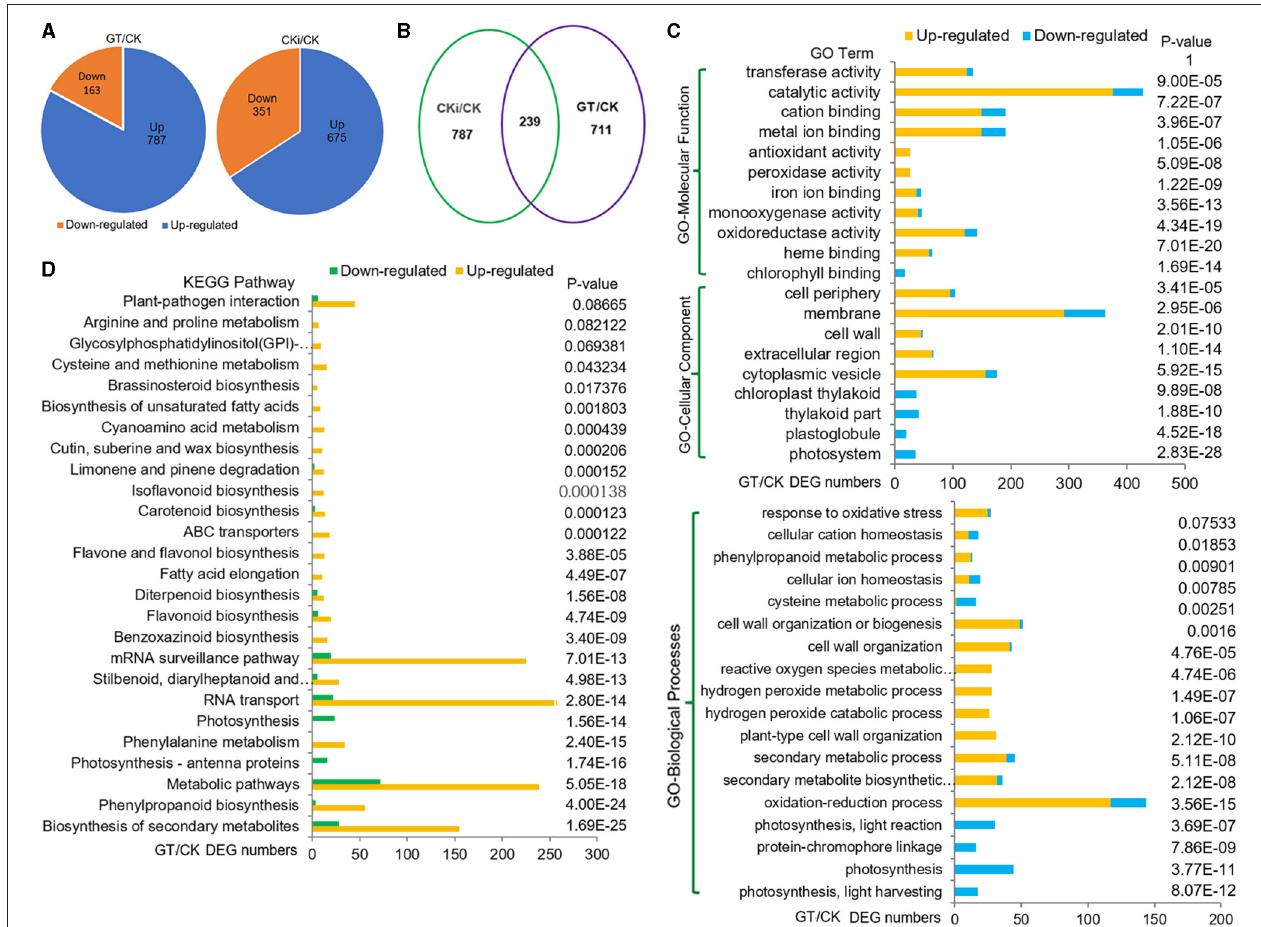
FIGURE 5 | Transcriptome reprogramming induced by the knockdown of ZmGT-3b . (A) Compared with CK (maize inbred line LH244, wild type), ZmGT-3b knockdown induced a differential expression of 950 genes (GT/CK), while the inoculation with F. graminearum induced a differential expression of 1,026 genes (CKi/CK). GT represents the values from transgenic seedlings grown under normal conditions without inoculation, CK and CKi represent control seedlings without or with inoculation, respectively. (B) 239 differentially expressed genes (DEGs) were overlapped between CKi/CK and GT/CK. Gene Ontology (GO) (C) and Kyoto Encyclopedia of Genes and Genomes (KEGG) pathway (D) functional analyses of the DEGs from GT/CK. Photosynthesis-related processes were reduced, and defense response-related biological processes were enhanced by ZmGT-3b